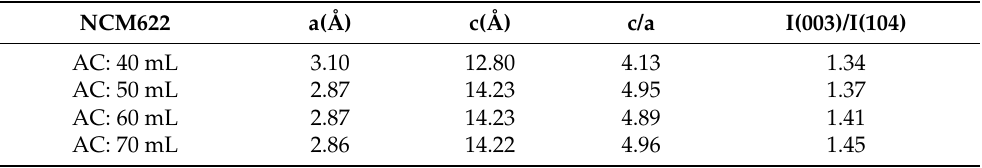
Table 2. XRD parameters of NCM622 different ammonia